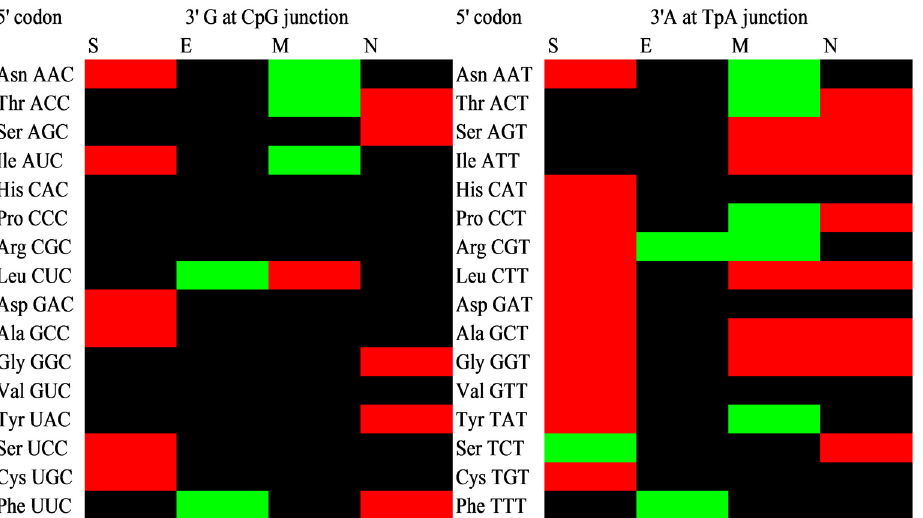
Figure 2. Dinucleotide bias context analysis of CpG and TpA dinucleotide at p3-1 junction. Positive context has been demonstrated with green color, while negative context has been demonstrated with red. Insignificant context (between 15 and − 15) is depicted as black color.